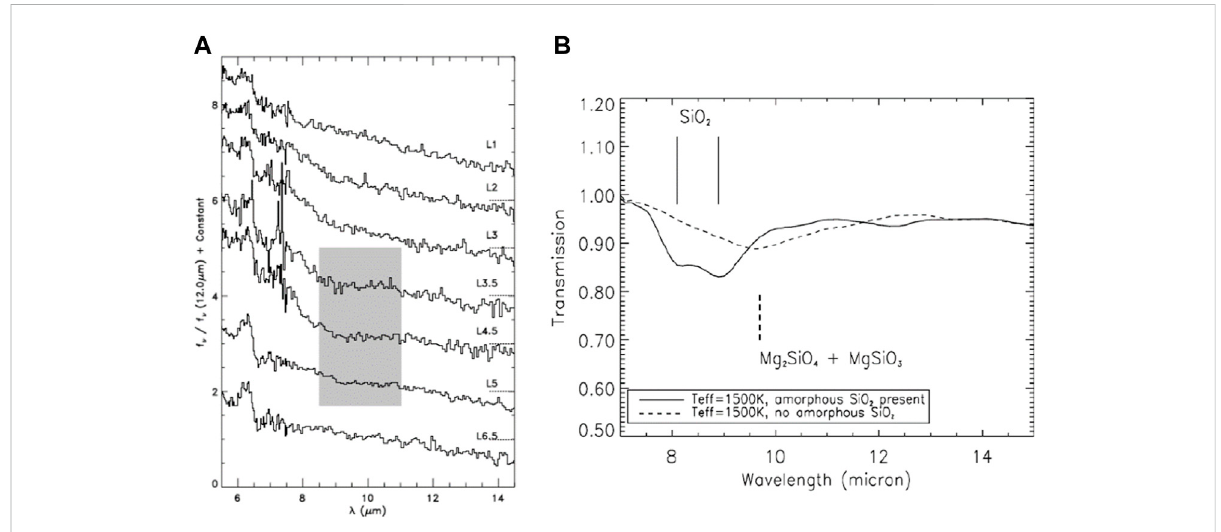
FIGURE 1 (A) IR Spitzer spectra of various exoplanetary atmospheres. The gray box indicates the wavelength range of the silicate absorption (Si-O stretching,9 – 11 μ m)andobjectsthatexhibittheplateau.Reproducedwithpermissionfrom(Cushingetal.,2006) © AAS. (B) Absorptiontransmission spectrum for the model with (solid line) and without (dashed line) formation of SiO 2 . Reproduced with permission from (Helling et al., 2006) ©